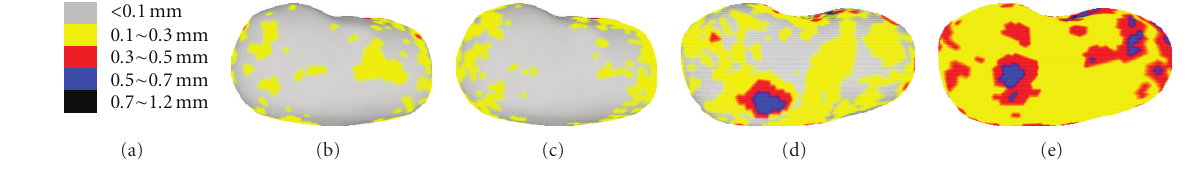
Figure 17: Representation error in intramodel experiment: (a) color-coded scales, (b) example representation error in training set, (c) 90% representation error in training set, (d) example of representation error in testing set, and (e) 90% representation error of testing set.